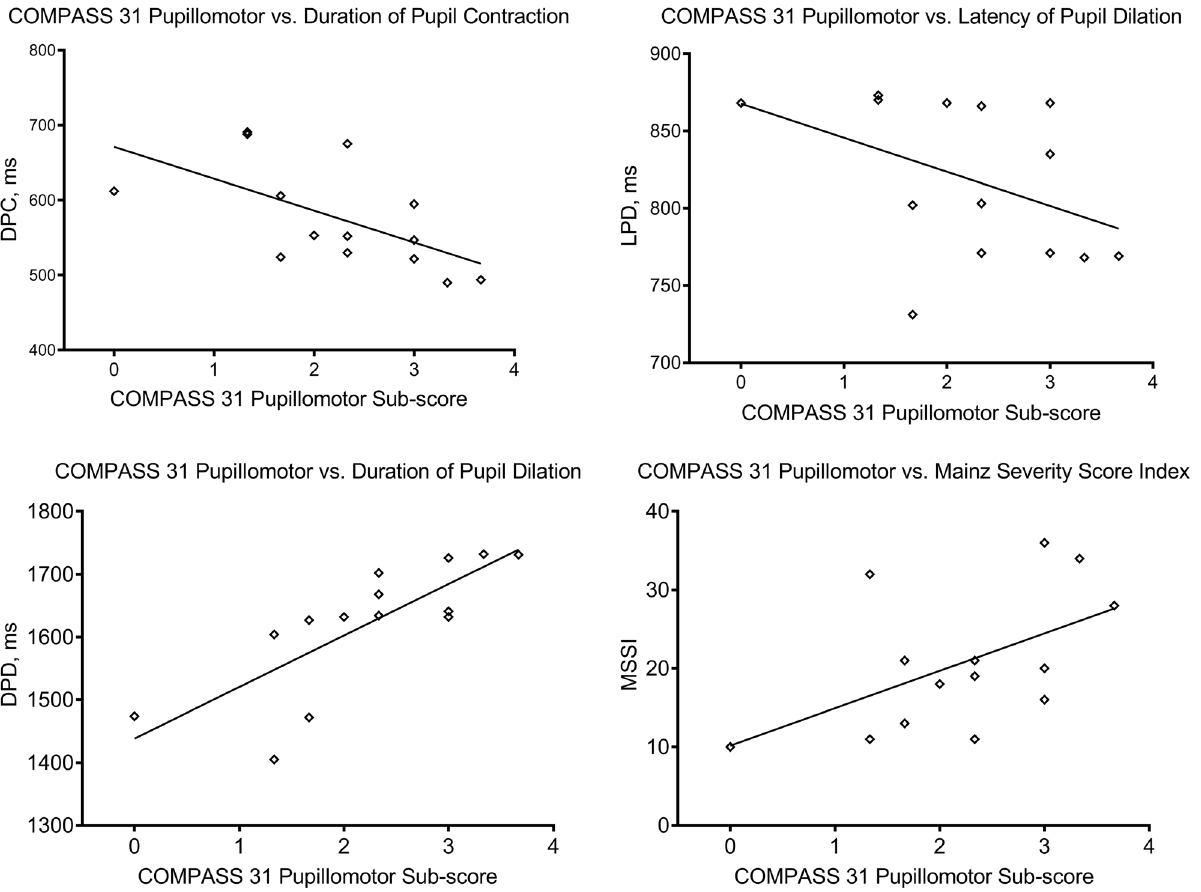
Figure 3. Scatter-plot graphs showing a significant correlation of the pupillomotor weighted sub-score of COMPASS 31 with the duration of pupil contraction ( r = − 0.600; P = 0.023), latency of pupil dilation (ρ = − 0.541; P = 0.046), duration of pupil dilation (ρ = 0.877; P < 0.001), and MSSI ( r = 0.533; P =